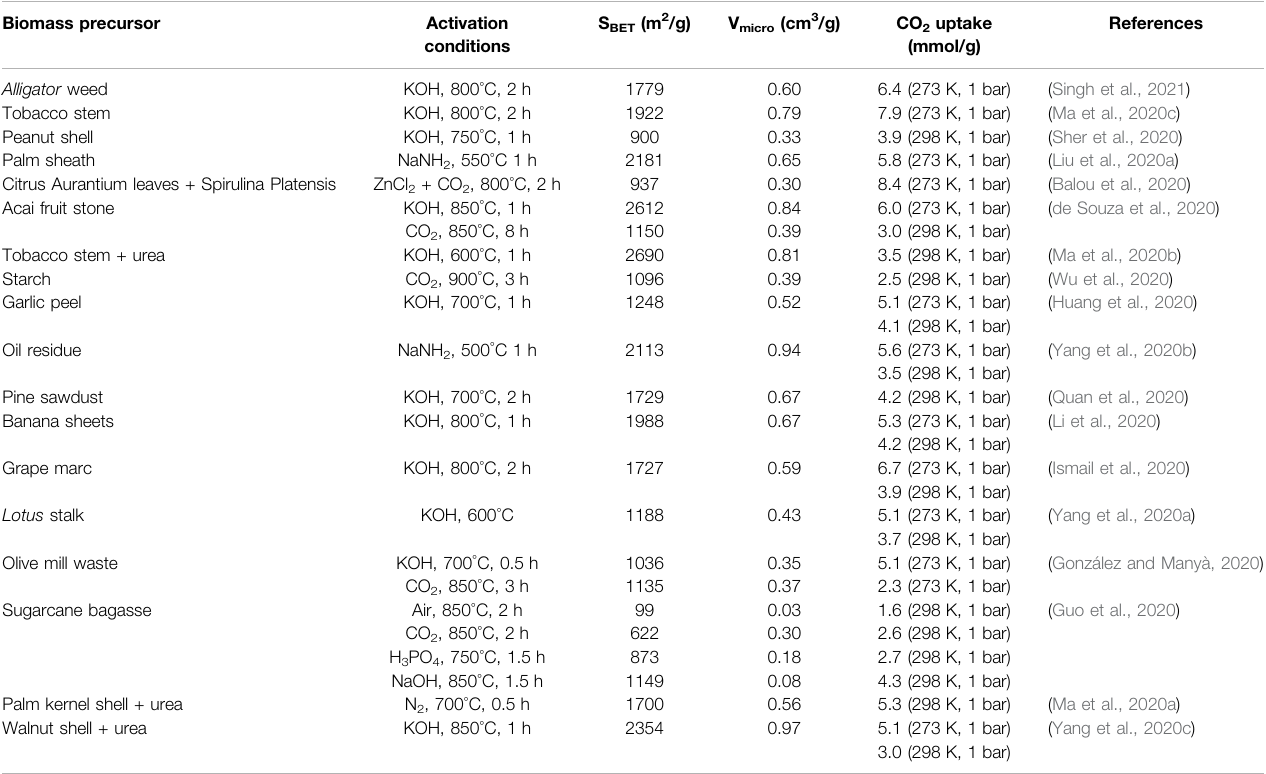
TABLE 1 | Recent literature (2020 — 2021) of CO 2 uptake with biomass-derived porous carbons. Biomass